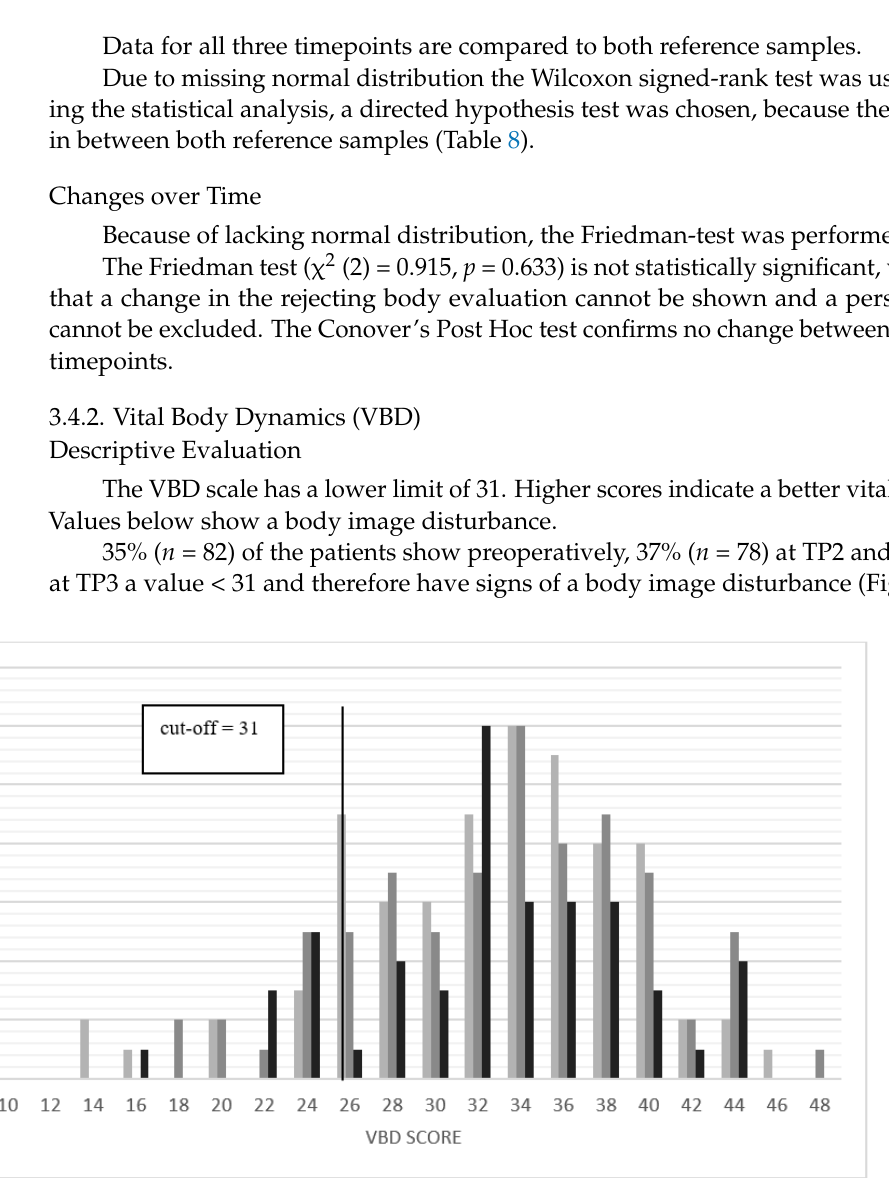
Figure 2. Overview over the distribution of the RBI scores (FKB-20). notes: black bars represent the RBI score at TP1 ( n = 82), light grey bars at TP2 ( n = 80) and dark grey bars at TP3 ( n = 55).